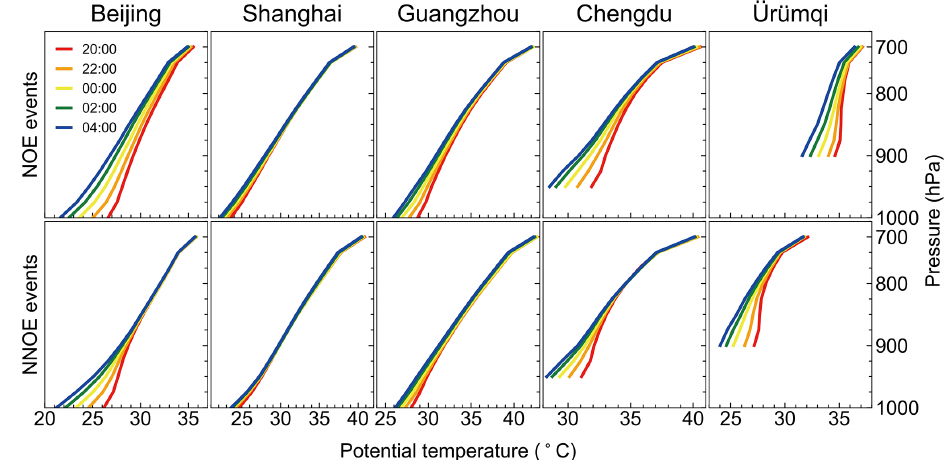
Figure 7. Comparison of the vertical profiles of potential temperature at five typical cities between the NOE (top row) and the NNOE (bottom row) events. The colored lines represent potential temperature profiles at different times of the night. The temperature data are from the ERA5